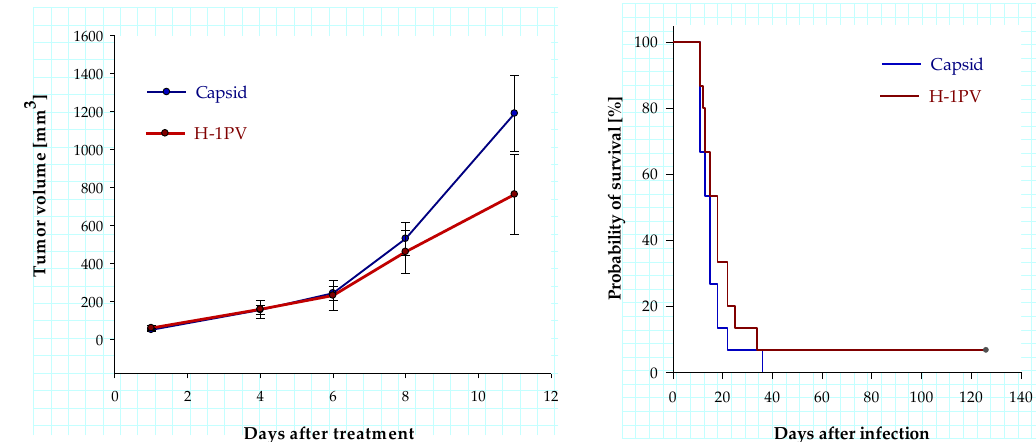
Figure 7. H-1PV infection represses the growth of subcutaneous TC-71 xenograft tumors in mice. Mean tumor volume in animals after a single intratumoral injection with empty, UV inactivated H-1PV capsids (control group, n = 15, blue graph). Animals in the treatment group ( n = 15, red graph) received a single intratumoral injection of 10 9 PFU wild-type H-1PV. For each group of animals, the standard errors of the mean (SEM) are indicated as error bars. Survival data for the two groups of animals show no statistically significant difference, but indicate one animal in complete long-term remission after H-1PV virotherapy.